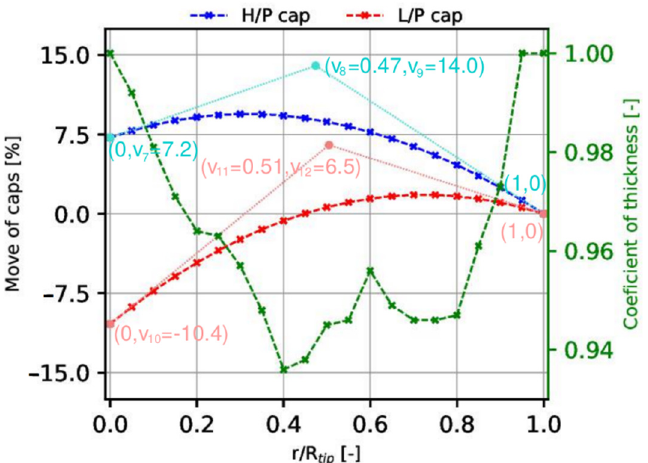
Figure 6. Geometric FEC (CASE B): span-wise distributions of percentage shift in the caps relative to the chord and global coefficient for the cross-section thickness (with green color). Cyan and orange symbols depict control points, connected with straight lines.